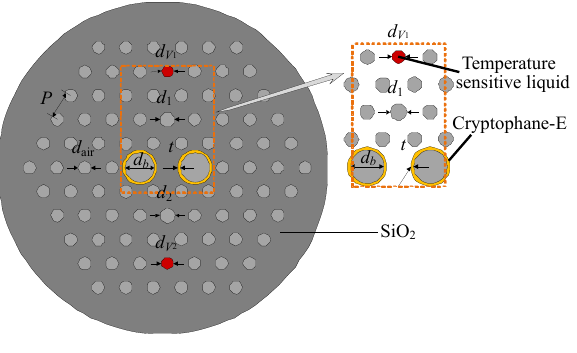
Fig. 1 Cross-section of the